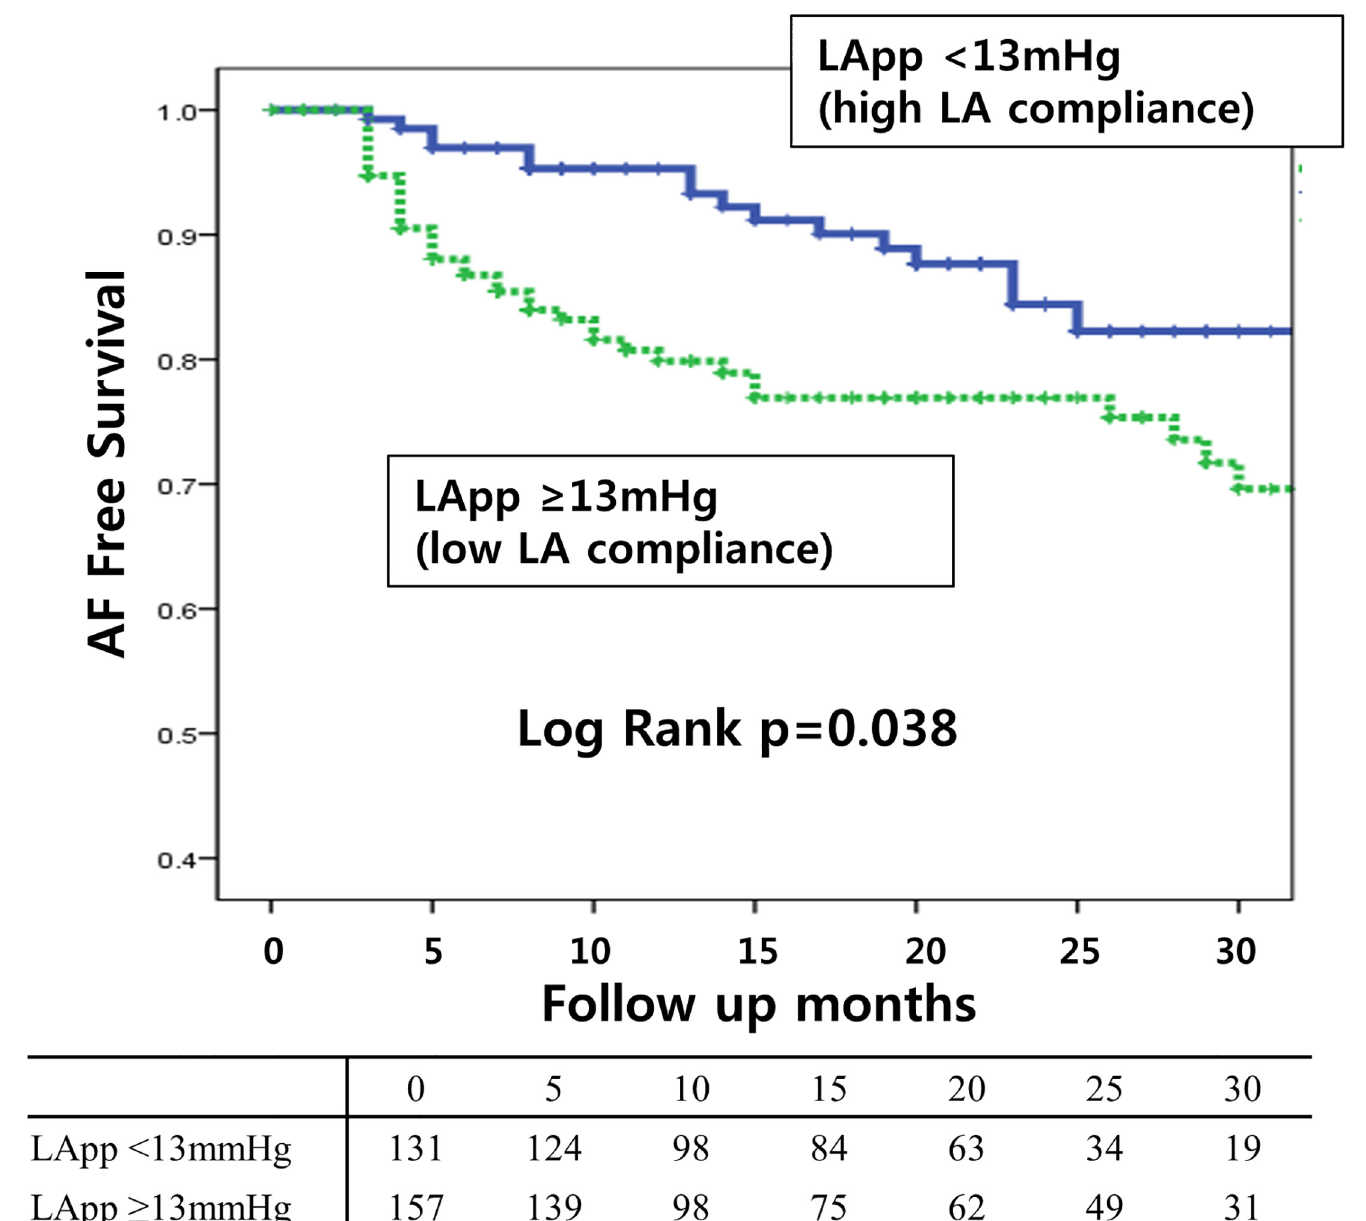
Fig 3. Patients with low LA compliance (LApp (cid:1) 13mmHg) have a higher recurrence rate than those with high LA